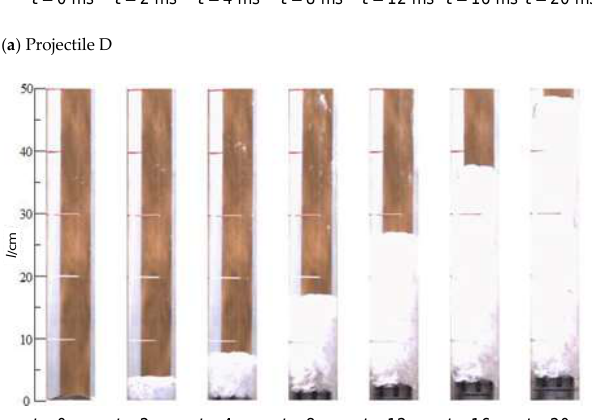
Figure 10. Gas-curtain displacement under different groove numbers. 0 t /ms Projectile B Projectile D Projectile E Figure 11. Projectile velocity under different groove numbers.